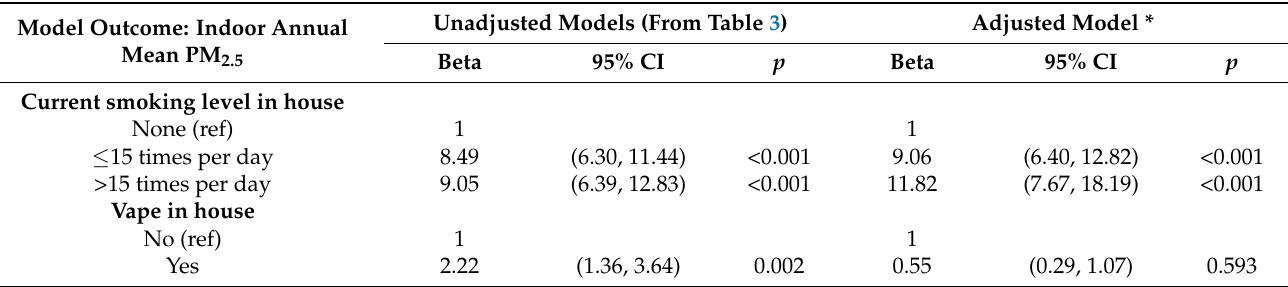
Table 5. Results of smoking and vaping